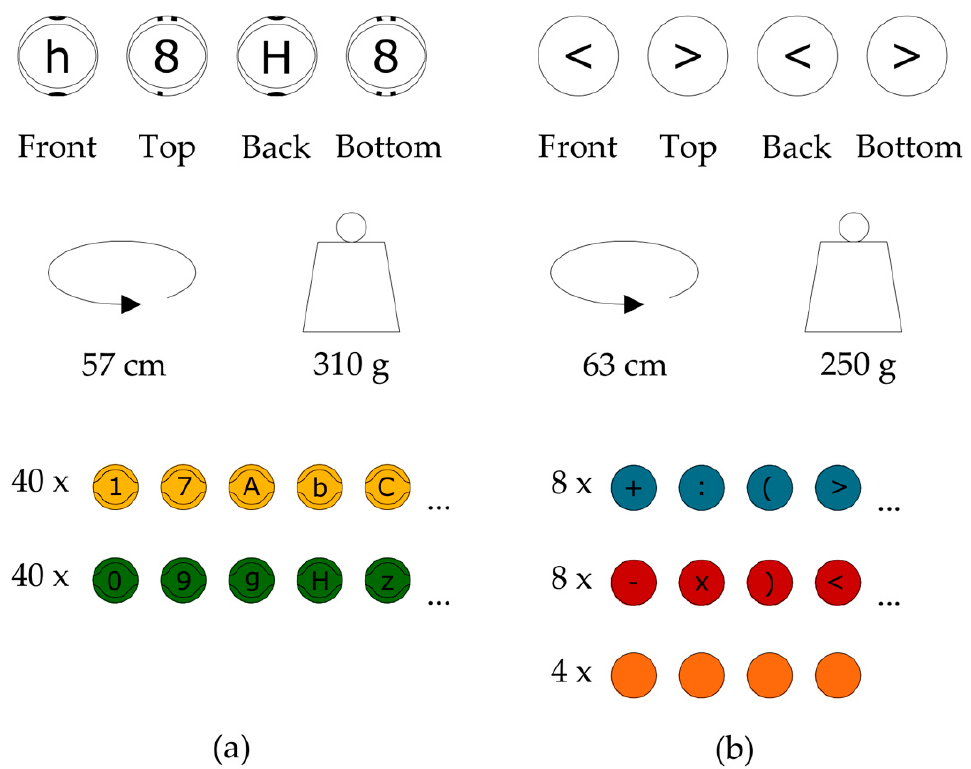
Figure 1. Eduball set. Balls used in the experiment were divided into two main subcategories. ( a ) The first type of balls (57 cm in circumference and 310 g of weight; close to size 3 basketballs) are in yellow and green colors (40 in each color) on which are printed black letters (on one side uppercase and on the opposite side lowercase) and numbers (from 0 to 9; the same digit on the top and bottom side); ( b ) the second type of balls (63 cm in circumference and 250 g of weight; close to size 4 volleyballs) are in blue and red colors (eight in each color) on the surfaces of which mathematical symbols are painted (representing the operations of addition, subtraction, multiplication, division, the symbols of greater than, less than, and parentheses), including the “at” sign (@), as well as four unprinted orange balls that can be used as universal blanks.